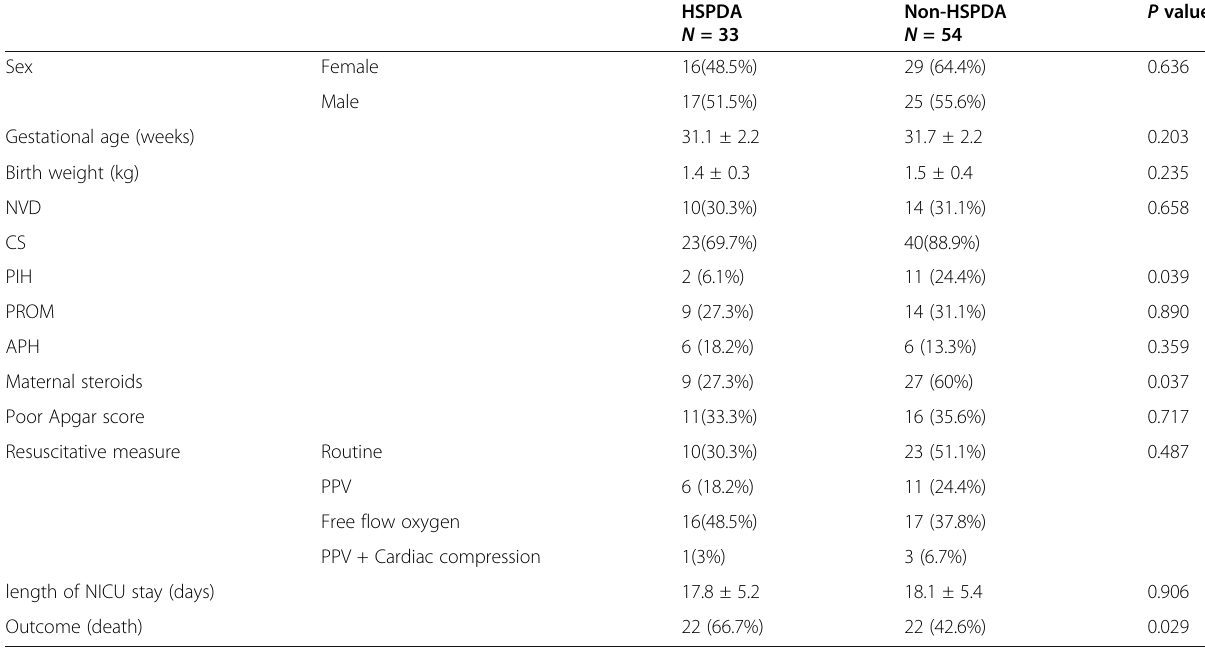
Table 3 Demographic and resuscitative data of PDA